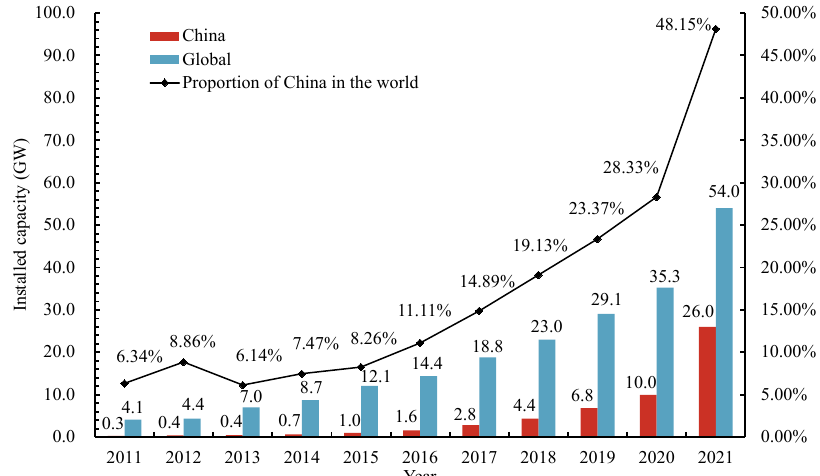
Figure 1. The total installed capacity of OWP over the years.